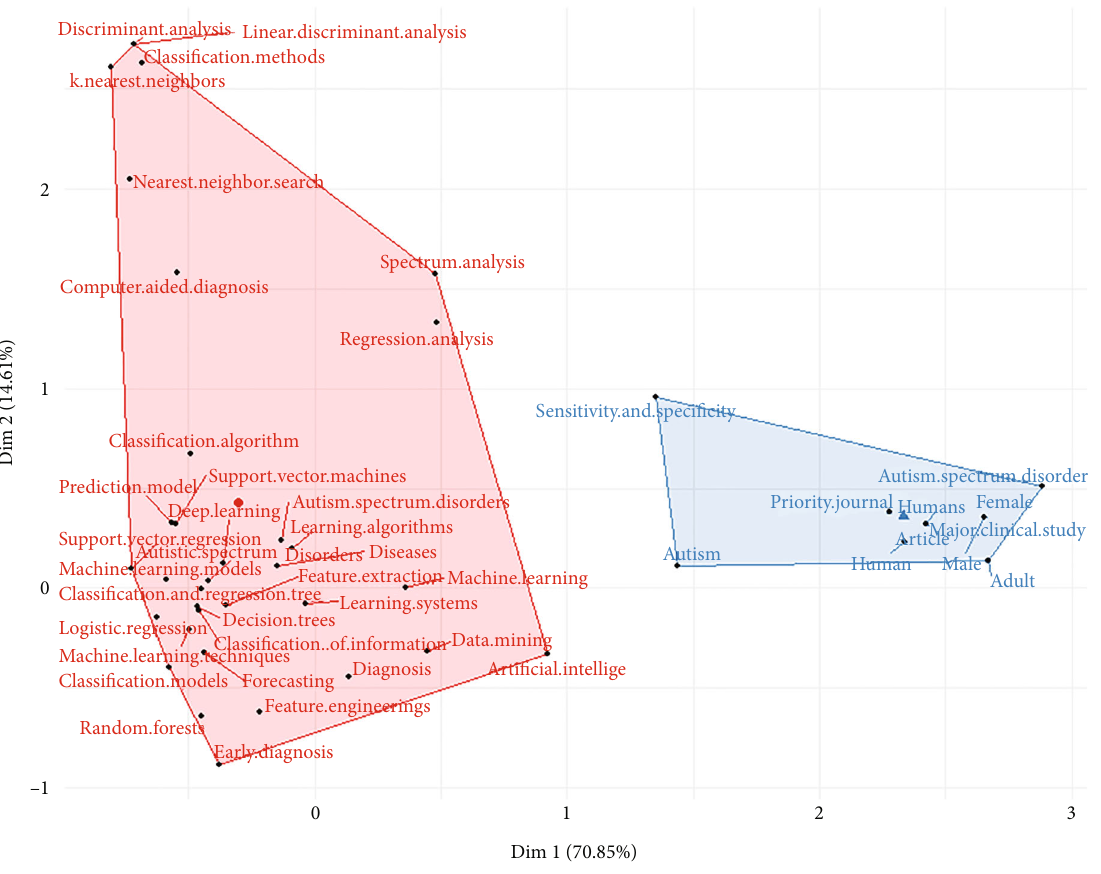
Figure 6: Conceptual structure